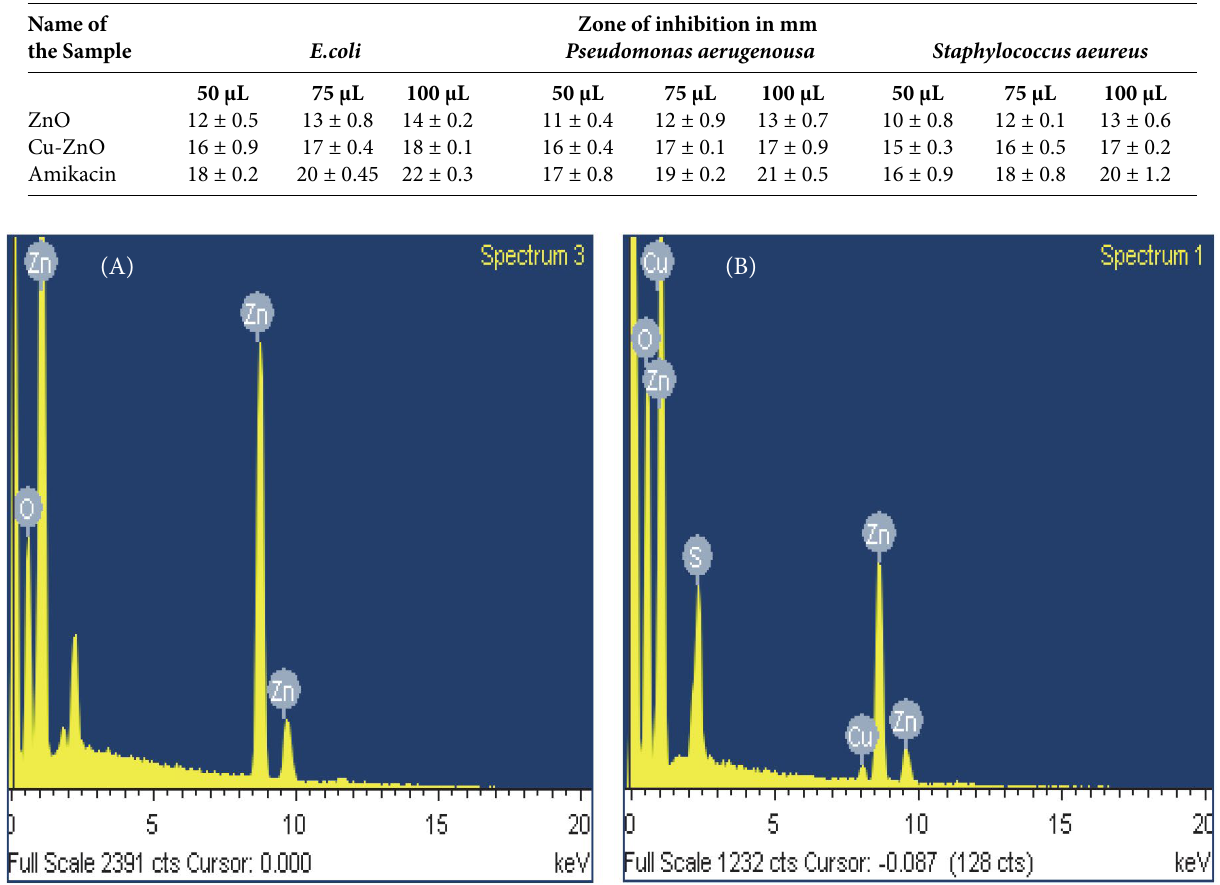
Figure 7. EDAX spectra of (A) ZnO and (B) Cu-ZnO NPs